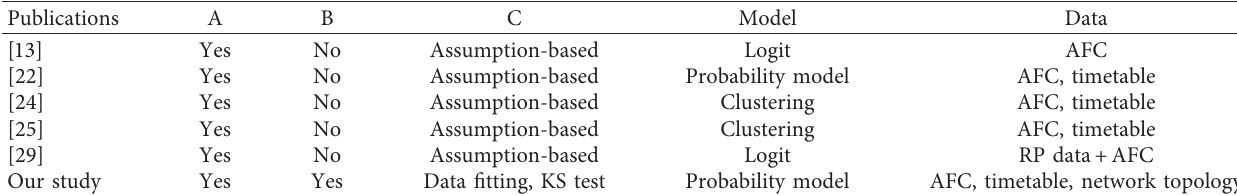
Table 1: Characteristics of relevant works in comparison with our